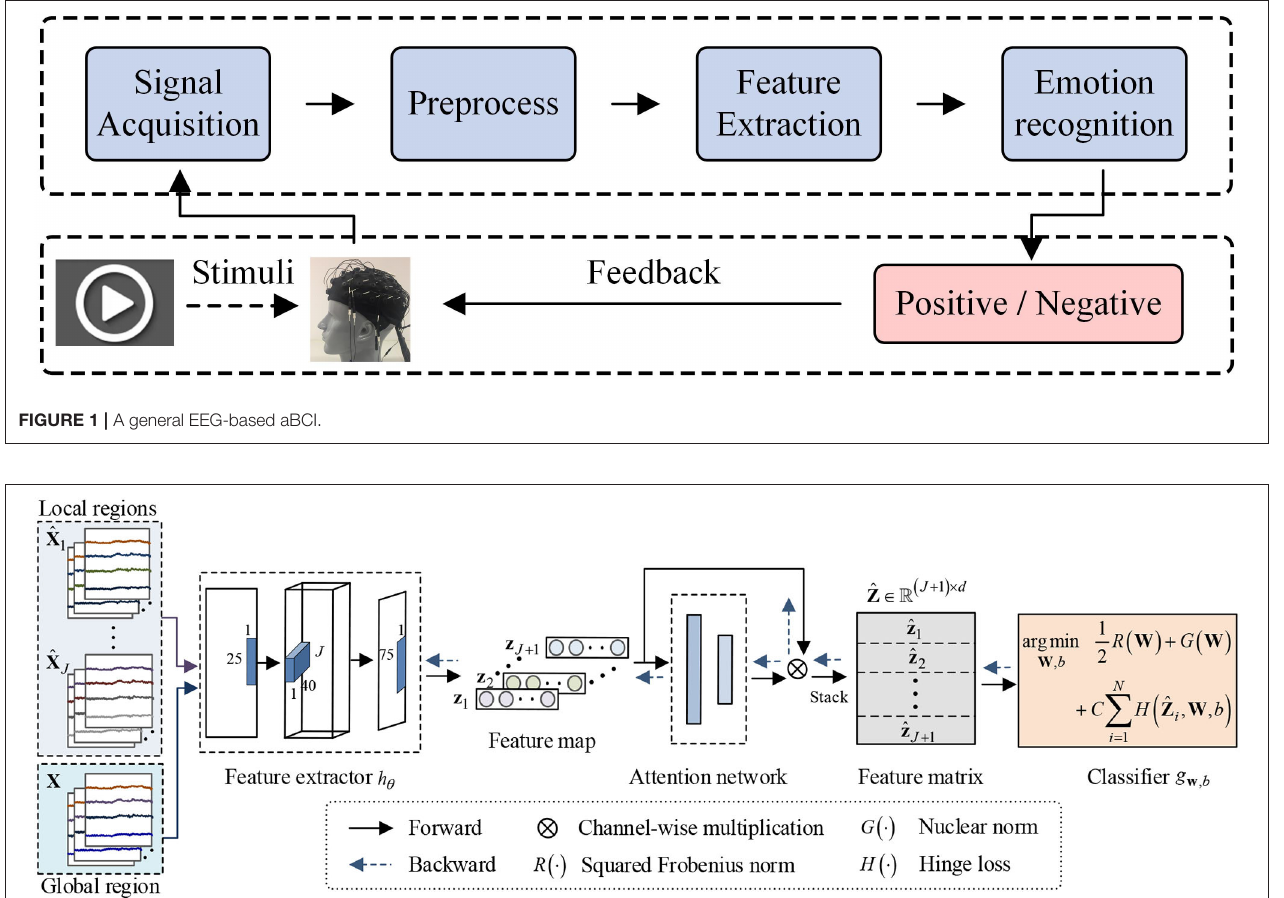
FIGURE 2 | Framework of the proposed NRDNN for EEG-based emotion recognition. NRDNN first utilizes deep neural networks to learn high-level feature representations of multiple brain regions. Then, a set of weights indicating the contributions of each brain region can be automatically learned using a region-attention layer. Subsequently, the weighted feature representations of multiple brain regions are stacked into a feature matrix, and the nuclear norm regularization is adopted to capture the structural information within feature matrix.